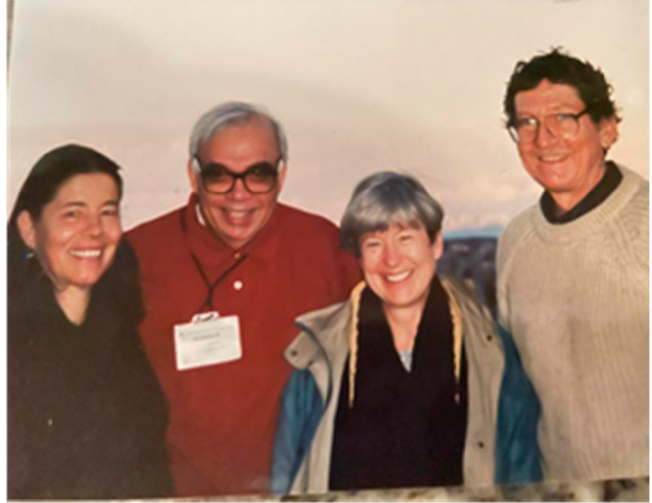
Figure 2. From right to left, Martin Pato, Geneviève Maenhaut, Nick Cozarelli and Ariane Toussaint (taken by Pat Higgins at a Keystone meeting in Santa Fe in the 1990s).